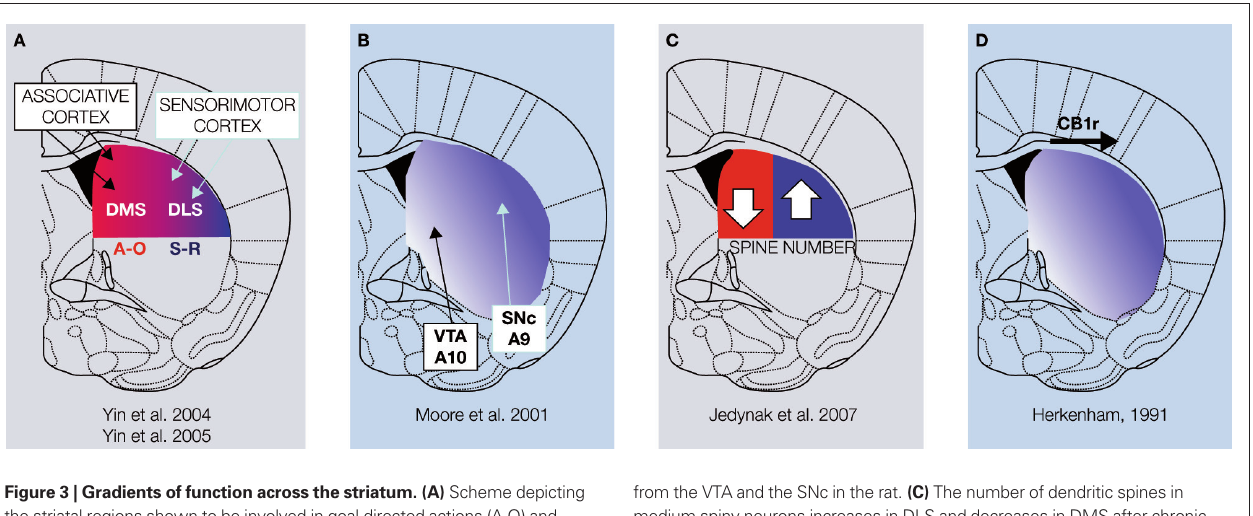
Figure 3 | Gradients of function across the striatum. (A) Scheme depicting the striatal regions shown to be involved in goal-directed actions (A-O) and habits (S-R). DMS-dorsomedial striatum; DLS-dorsolateral striatum. (B) Representation of the striatal areas innervated by dopaminergic neurons